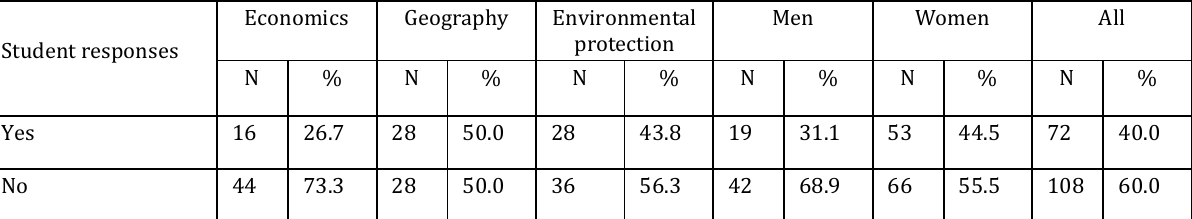
Table 8. The responses of the students to the question 20 - "Did you take an active part in any local action to protect the environment?" Economics Geography Environmental Men protection Student responses